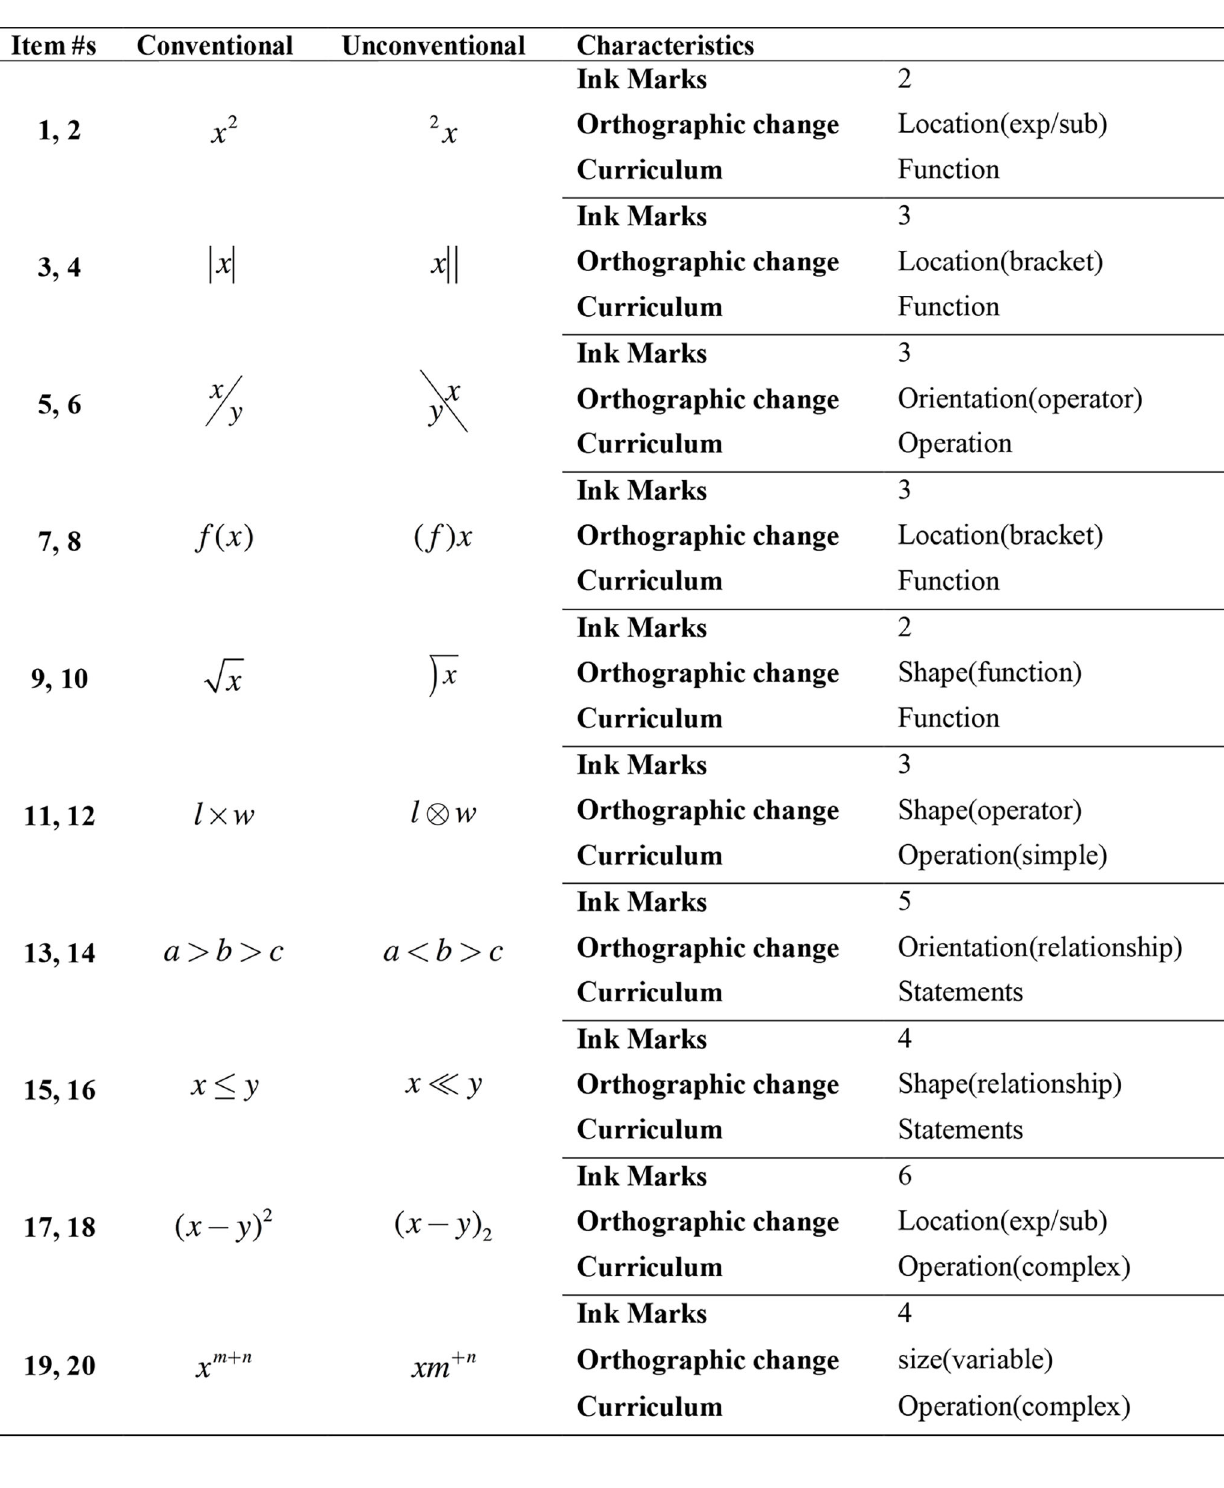
Table B.1. Experimental Stimuli for the Symbol-Decision Task for Math